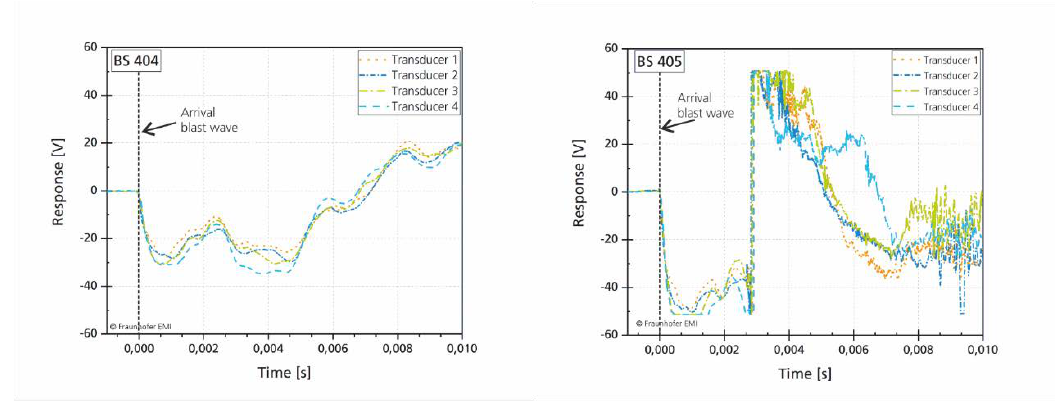
Fig. 7 Comparison of measured oscillations at sensors 1 to 4 from 1 ms before arrival of the pressure wave up to t = 10 ms for test BS 404 (left) and BS 405 (right).